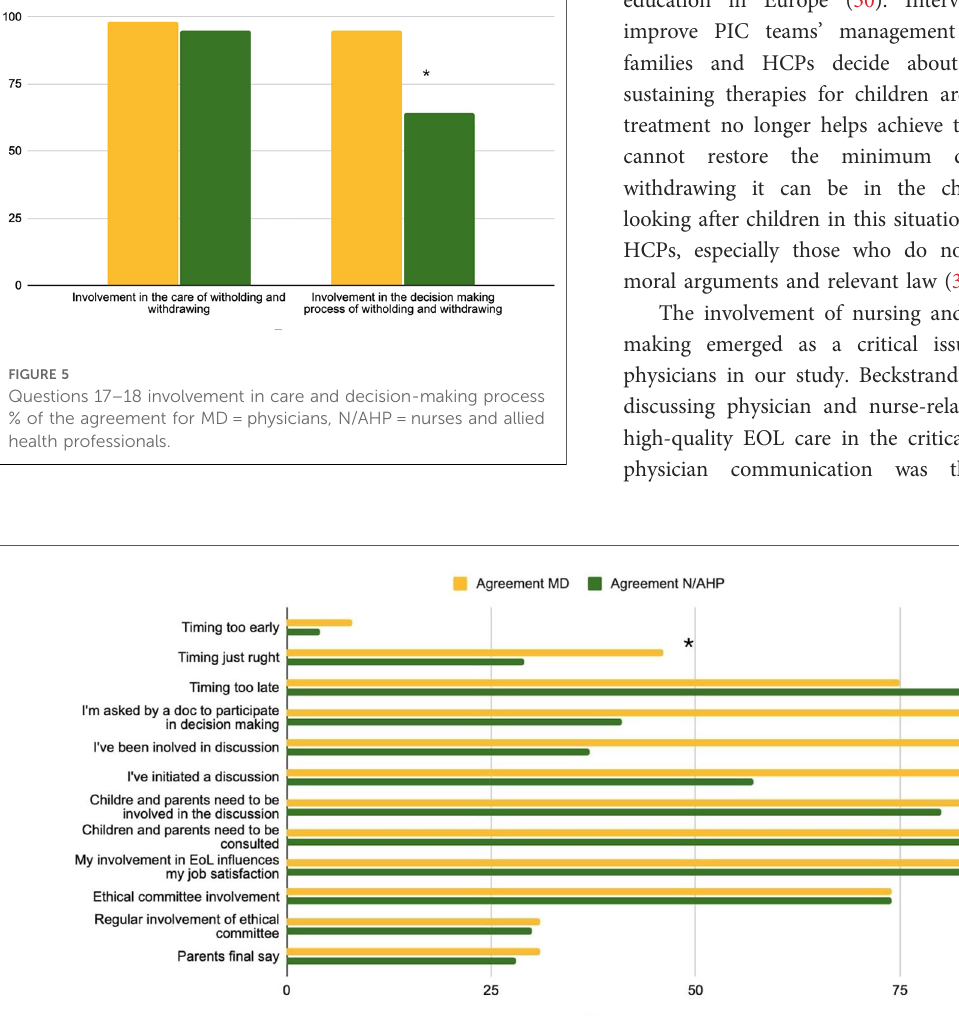
FIGURE 6 Questions 19 – 30. Involvement in End of Life (EoL) decision % of the agreement for MD=physicians, N/AHP=nurses and allied health